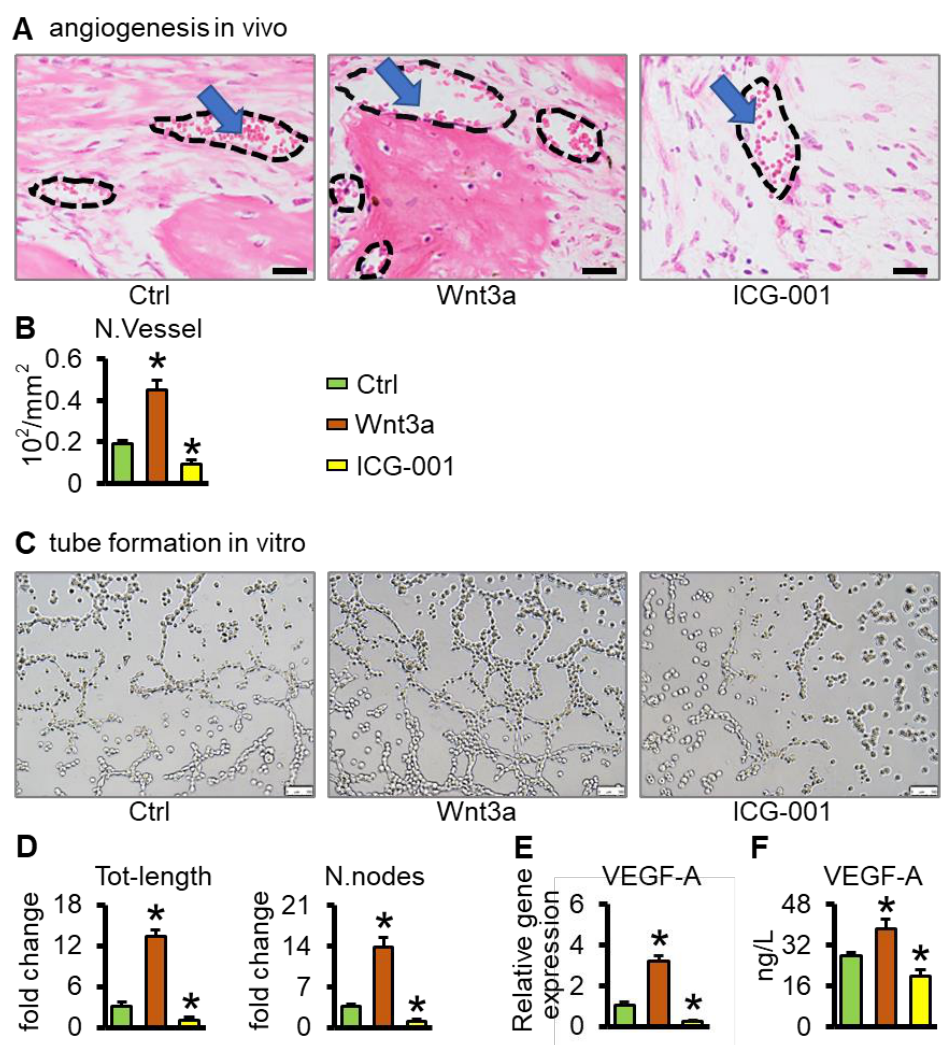
of bone defect at 8 weeks after surgery (green circle is the ctrl group, the brown circle is the Wnt3a group, the yellow circle is the ICG-001 group) and ( C ) quantitative analysis of the bone area per the tissue area (B.A./T.A.). ( B ) HE staining of the tissue section at the bone defect; the white dotted area is polycaprolactone. HB, host bone. NB, New bone. ( D ) Static histomorphometric analysis, bone volume per tissue volume (BV/TV), osteoblast number per tissue area (N.Ob/T.Ar). Small figure,